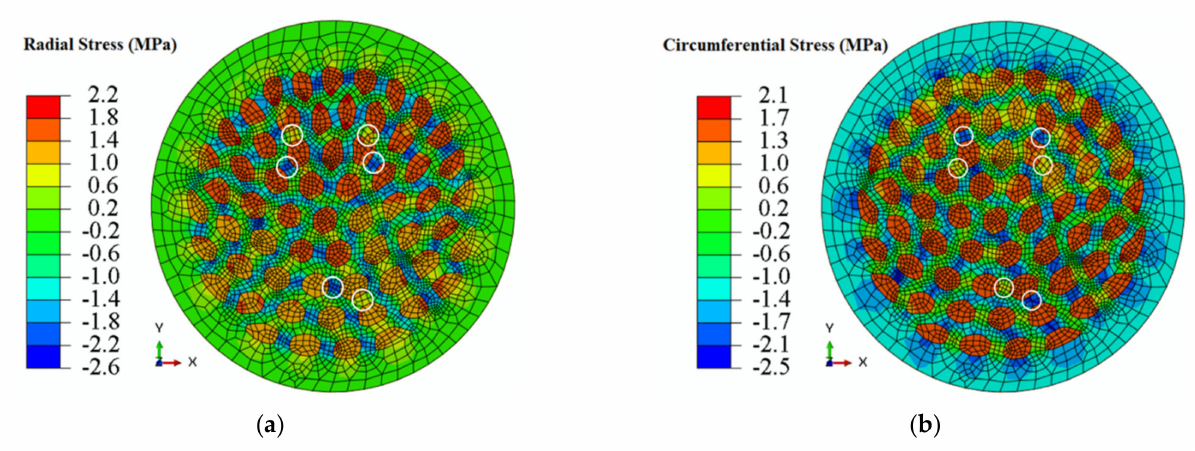
Figure 9. Simulation stress-strain curve of ≈ 25%Al-ACCA sample.